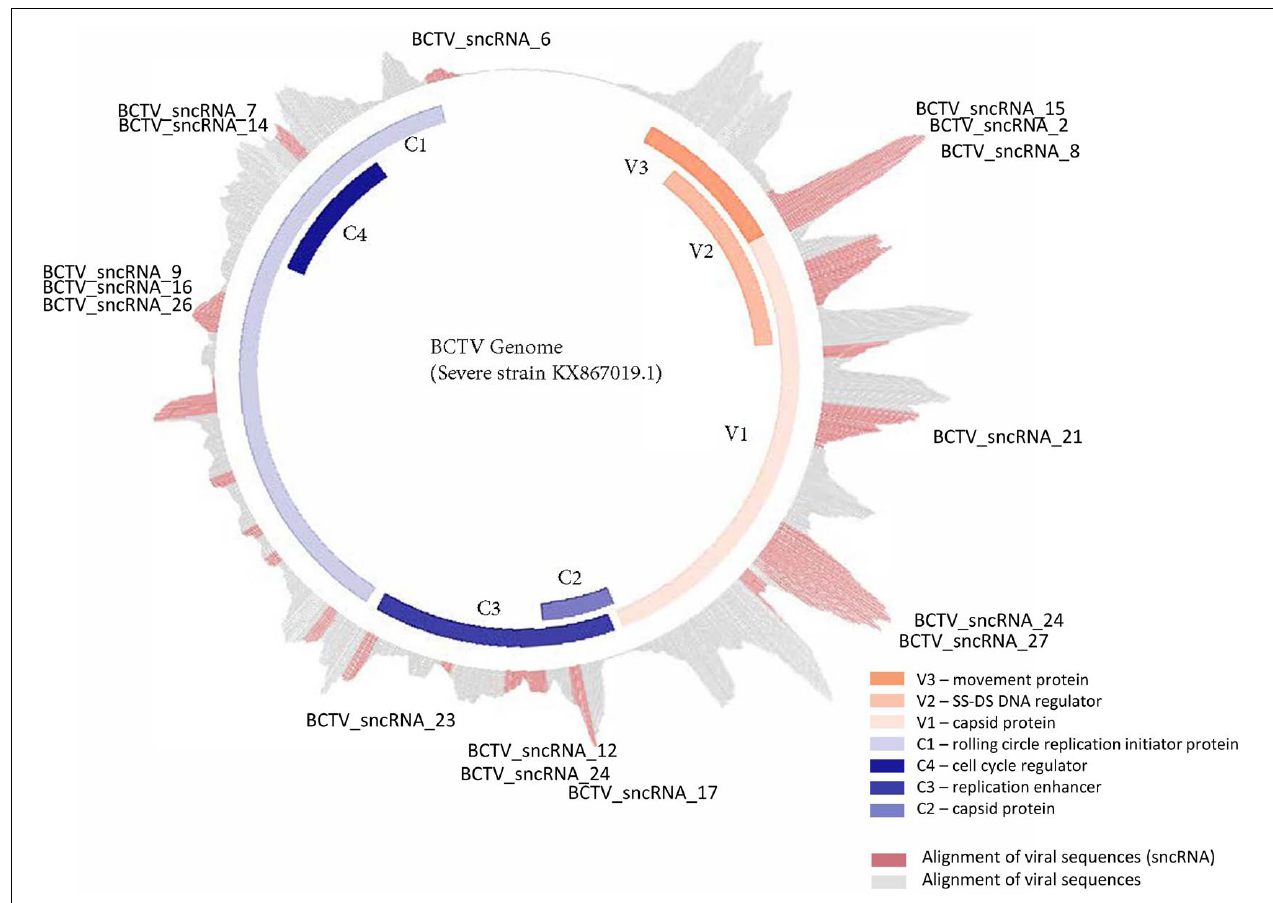
FIGURE 6 | Distribution and relative abundance of small non-coding RNAs originating from BCTV during its interaction with sugar